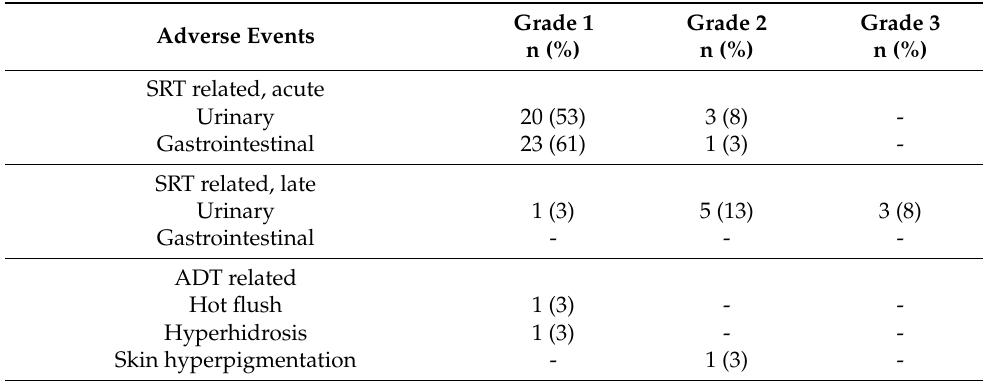
Table 3. Adverse events related to SRT or